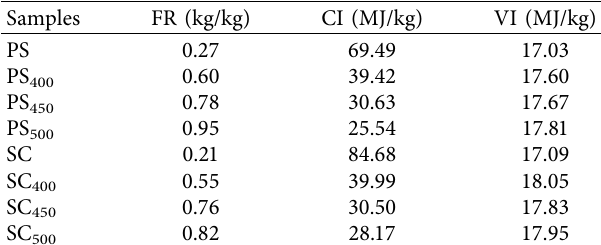
Table 4: Combustion indices of raw and pyrolysis biomass. Samples